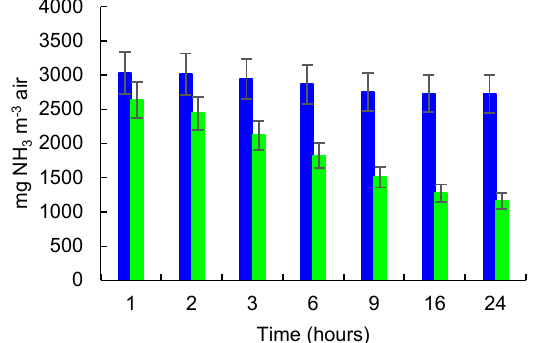
Figure 7. NH 3 released/adsorbed from 5 mL NH 4 OH solution 25%. NH 3 concentration (mg m − 3 ) in control box (blue color) and in box with zeolite (green color); error bars for 10% Ue rel are shown.